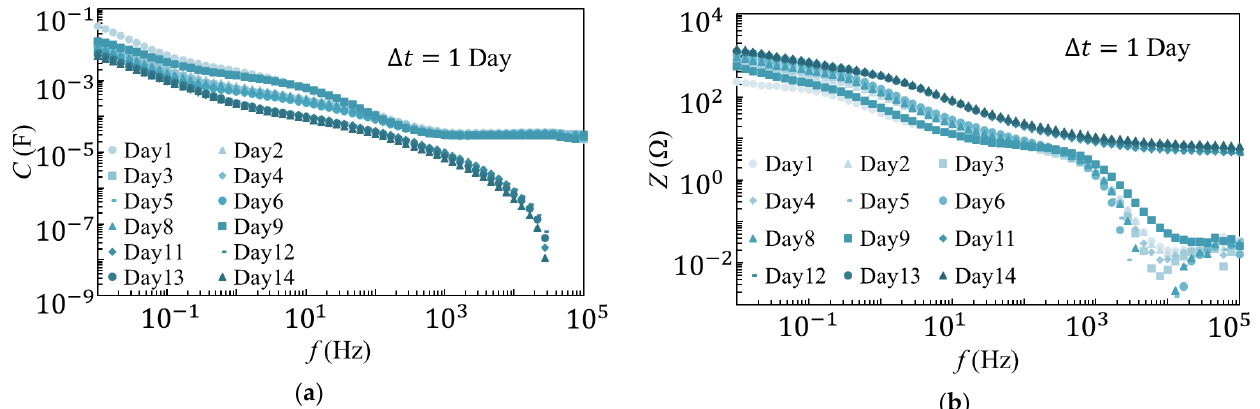
Figure 3. Results of ( a ) C and ( b ) Z measurements in the 80 °C degradation tests.